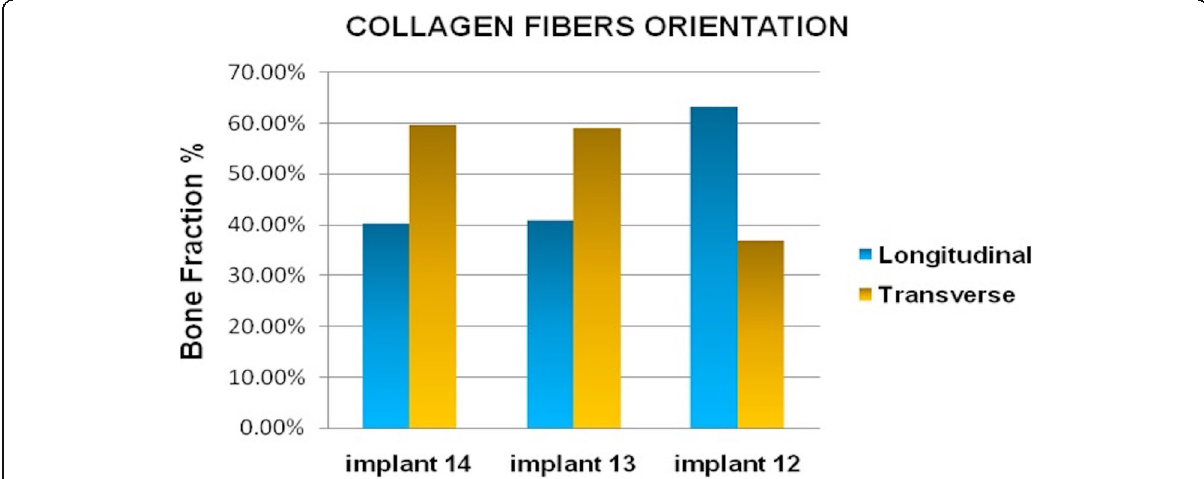
Fig. 5 Percentage of the collagen fiber orientation of each